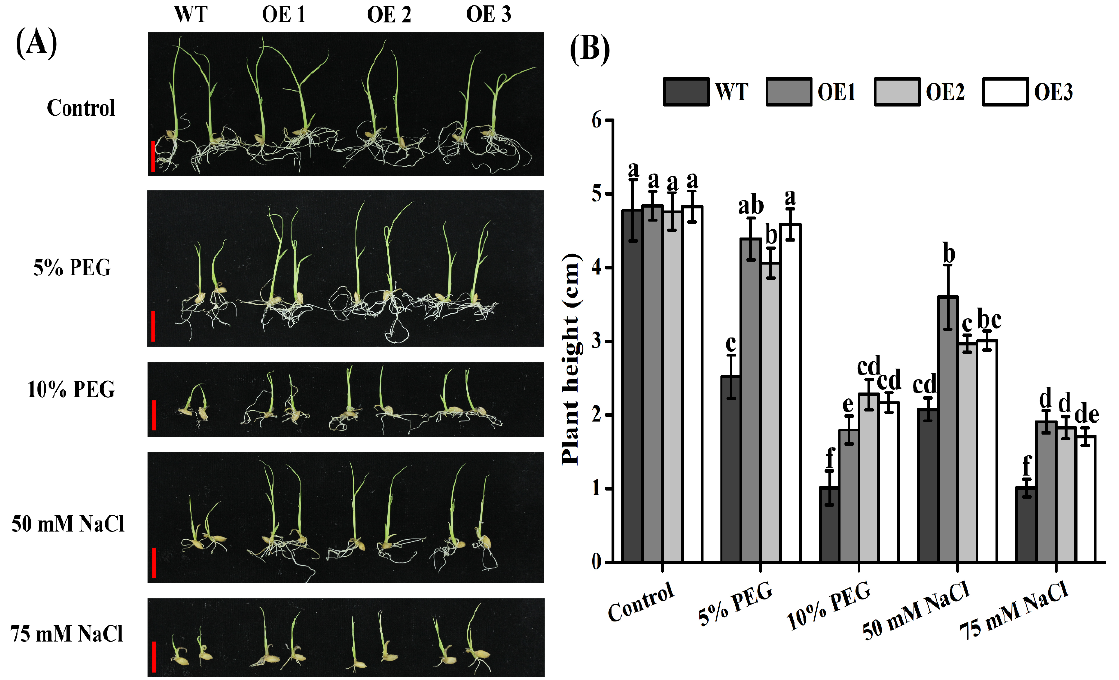
Figure 6. Effects of PEG6000 and salt on the growth of rice WT and transgenic lines. ( A ) Seedling growth performances. Three-day-old seedlings of WT and transgenic lines grown in liquid 1/2 MS medium were treated without or with 5% PEG6000, 10% PEG6000, 50 mM NaCl or 75 mM NaCl for another one week. Scale bars are 1 cm. ( B ) Plant height of all plants in ( A ). Data are mean ± SD (n ≥ 3). Diverse lowercase letters above the error bars represent that the height values of various plants were significantly different from each other by one way ANOVA and Tukey’s HSD test ( p <